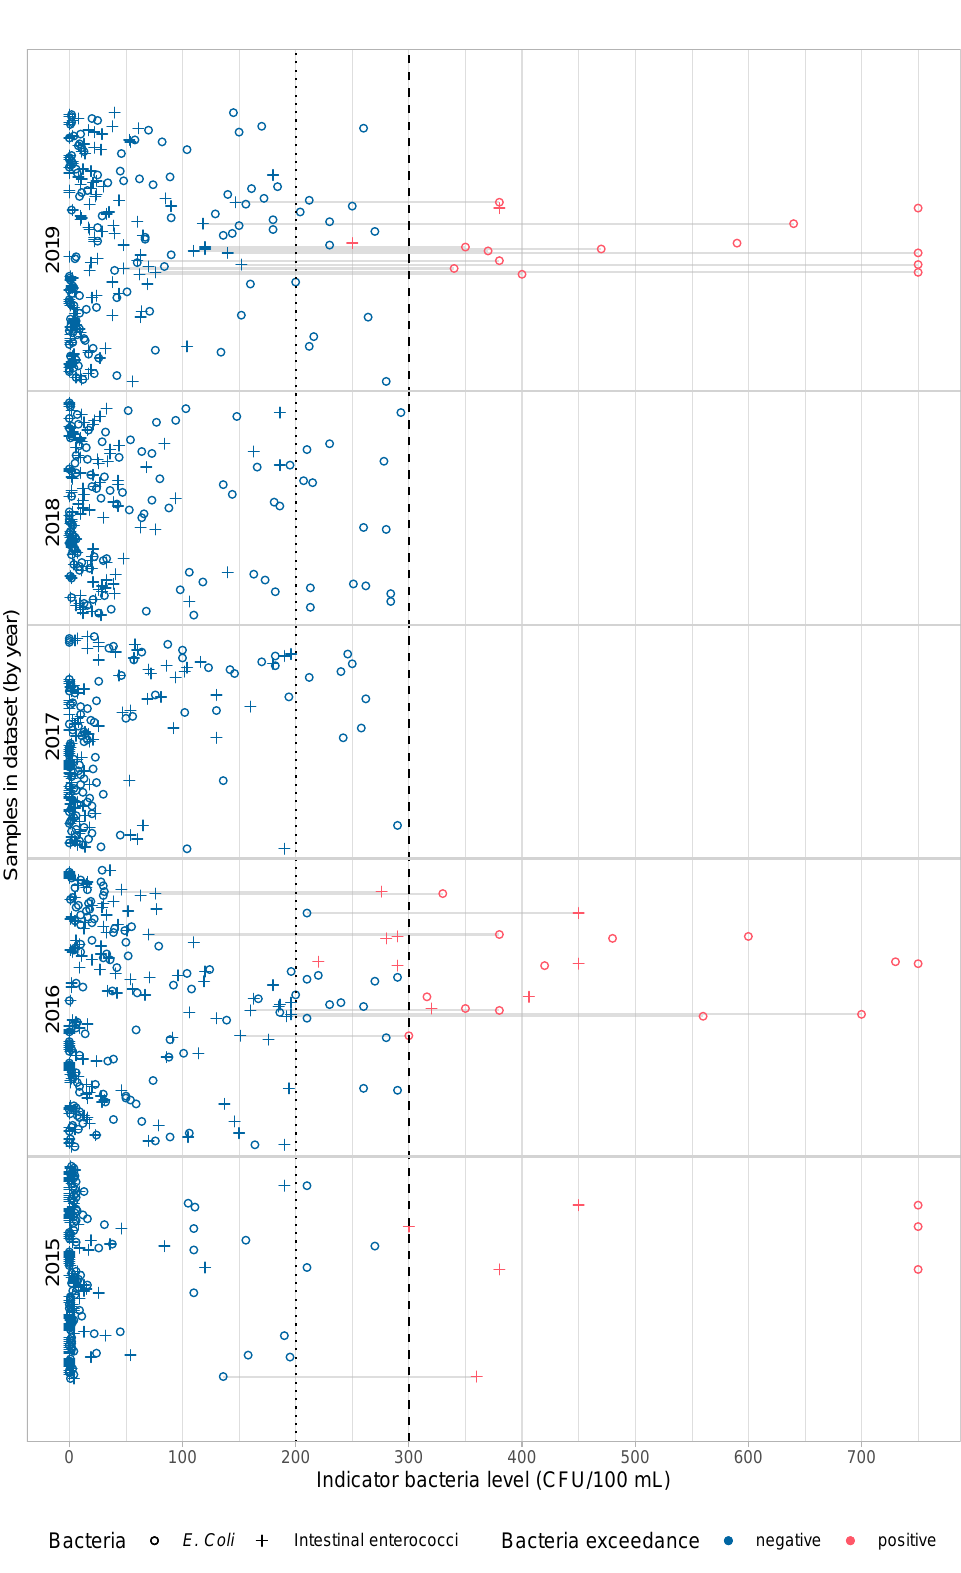
Figure 7. FIB level of samples from dataset, sorted by timestamp. Each sample is represented by a line, the circle being CFU/100 mL of E. coli and plus being CFU/100 mL of intestinal enterococci. Samples marked red represents poor